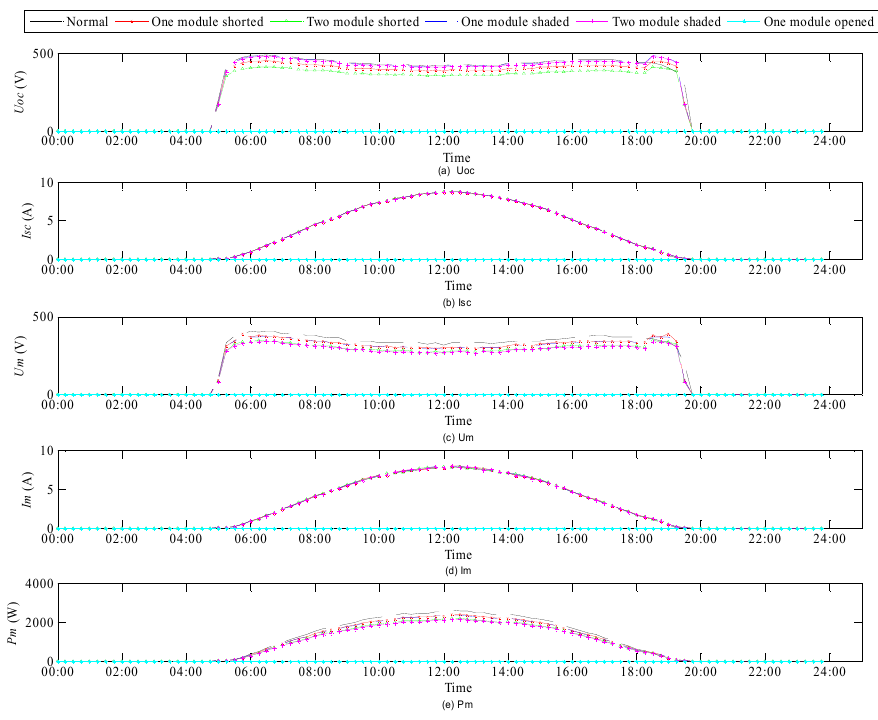
Figure 3. PV array electrical parameters change under different fault conditions, ( a ) Change in the electrical parameter U oc under different fault conditions; ( b ) Change in the electrical parameter I sc under different fault conditions; ( c ) Change in the electrical parameter U m under different fault conditions; ( d ) Change in the electrical parameter I m under different fault conditions; ( e ) Change in the electrical parameter P m under different fault conditions.